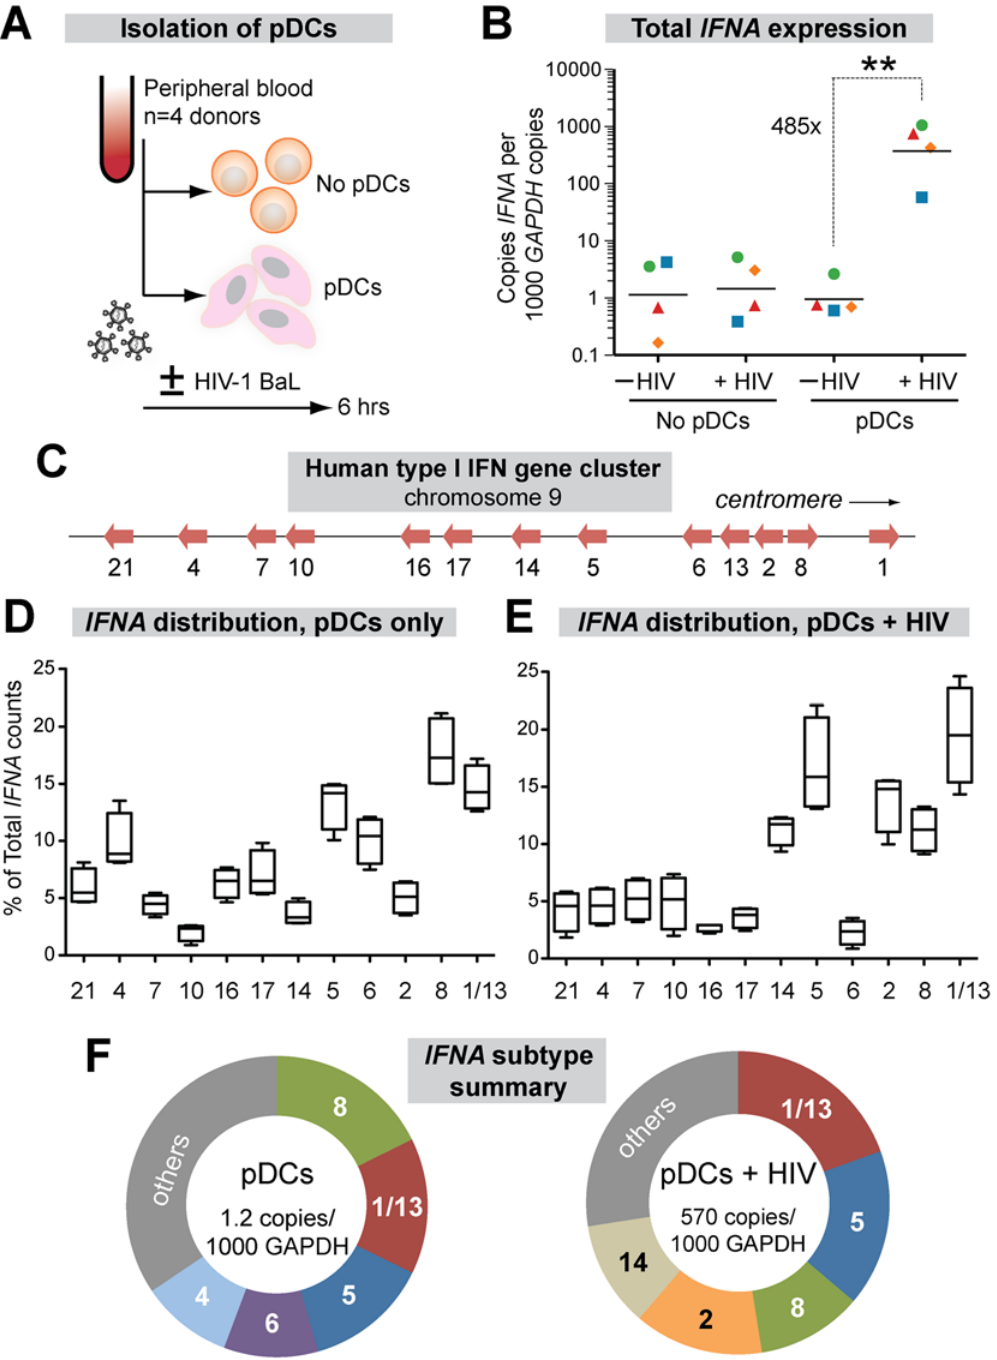
Fig 1. Expression of IFN α subtypes in pDCs following HIV-1 exposure. (A) Isolation pDCs. pDCs were enriched by negative selection from PBMCs of healthy donors (n = 4). Both pDC-enriched and pDC-negative fractions were exposed to 250 ng p24 of HIV-1 BaL by 2 hr spinoculation at room temperature and incubated 4 hr at 37°C. (B) Total copies of IFNA by qPCR normalized to 10 3 copies GAPDH . Each color/shape combination corresponds to one donor. Data were analyzed using a 2-tailed Student ’ s paired t-test. ** , p < 0.01. (C) Type I IFN gene cluster in human chromosome 9. (D, E) Percentage of total IFNA sequence counts for each IFNA subtype in (D) Mock or (E) HIV-1 BaL infection. IFNA subtypes on the x-axis were shown relative to chromosomal position. The values for IFNA1/13 were presented at the genomic position for IFNA1 . Box-and-whisker plots correspond to 25-75 th percentiles with bars corresponding to minimum and maximum values. Median values were indicated as solid lines within the boxes. (F) Relative abundance of the 5 predominant subtypes expressed in pDCs ± HIV-1 exposure.